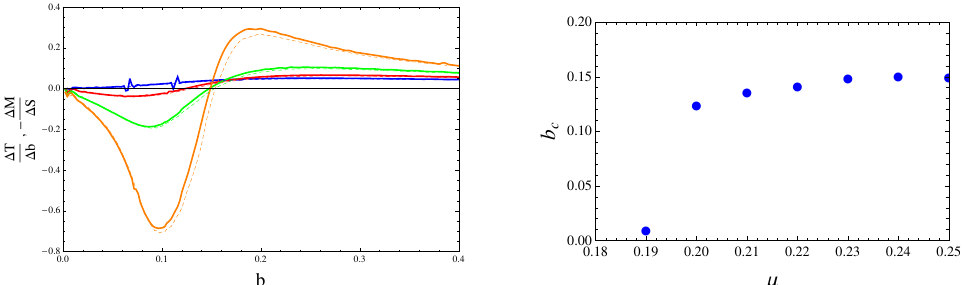
Figure 15 . Left panel: the ratios (cid:1) T= (cid:1) b (solid lines) and (cid:0) (cid:1) M= (cid:1) S (dashed lines) plotted as functions of the magnetic (cid:12)eld b for four di(cid:11)erent values of the chemical potential (cid:22) = 0 : 16 (blue), (cid:22) = 0 : 2 (red), (cid:22) = 0 : 23 (green) and (cid:22) = 0 : 25 (orange). Right panel: critical magnetic (cid:12)eld b c where IMC becomes MC as a function of the chemical potential (cid:22) . Note that the trigger of IMC occurs approximately at (cid:22) (cid:25) 0 : 19 where b c starts increasing from